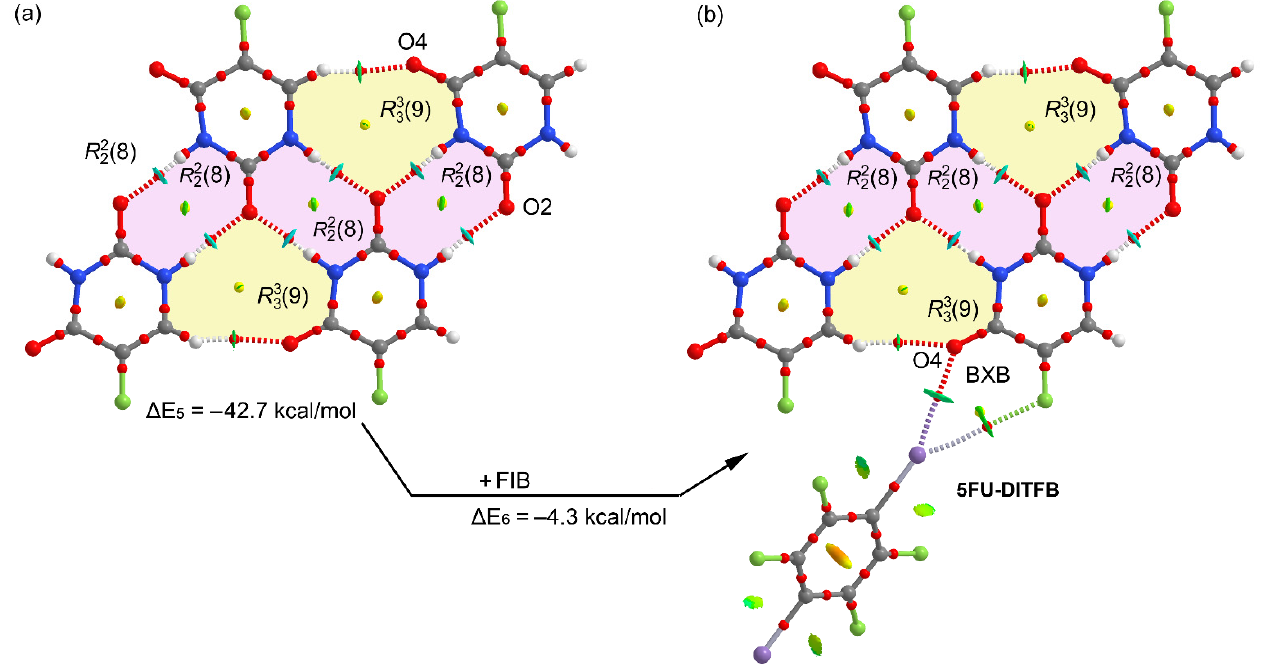
Figure 8. ( a ) QTAIM distribution of bond and ring CPs (red and yellow spheres, respectively) and NCIplot of the tetrameric assembly of compound 5FU-TFDIB. ( b ) QTAIM distribution of bond and ring CPs (red and yellow spheres, respectively) and NCIplot of the pentamer of compound 5FU-TFDIB. The formation energies ( ∆ E) computed at the PBE0-D3/def2-TZVP level of theory are also